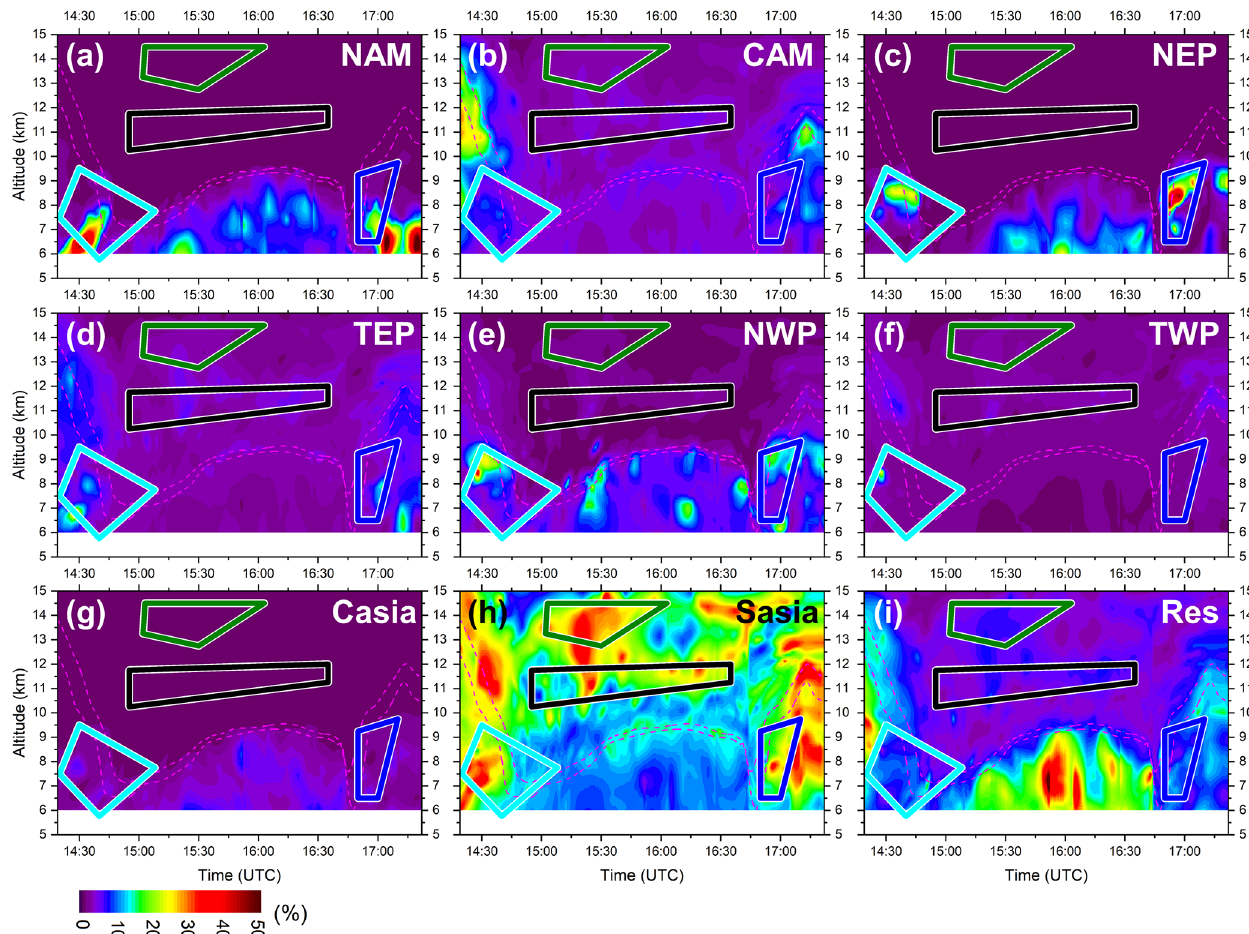
Figure 11. Artificial tracers of air mass origin calculations performed with CLaMS for the GLORIA observation grid showing the horizontal and vertical distributions of fraction of air originating from the boundary layer of different geographical regions as defined in Fig. 10. Results are shown for zones from the North American, Central American, and Pacific regions (a–f) and zones for Central Asia (g) and South Asia (Sasia), which comprise the subregions INO, IND, NIN, TIB, ECH, BoB, SEA, and Wpool (g) . The residual part (Res) displayed in ( i ) includes all global regions except the zones shown in (a–h) and is of little importance for the GLORIA observations. Annotations as per Fig.